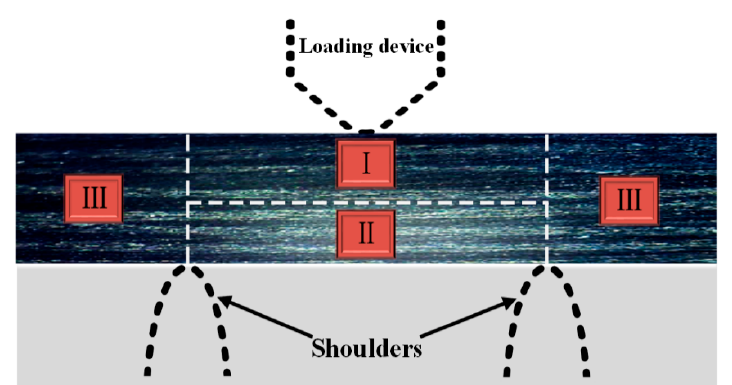
Figure 8. Division of the CFRP specimen.